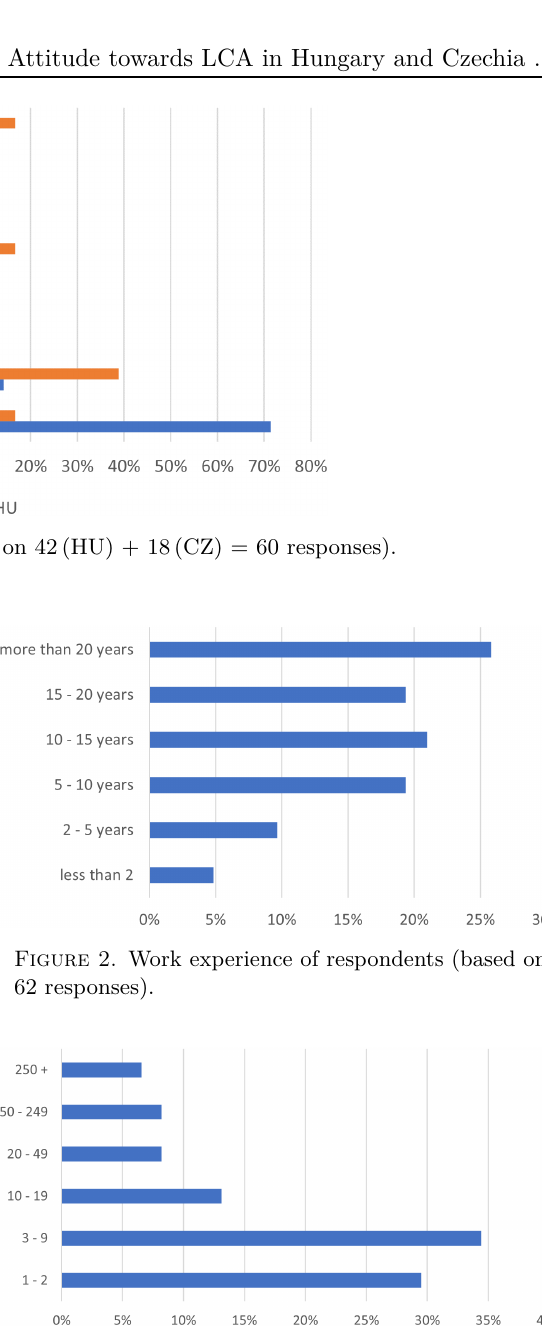
Figure 3. Number of employees in the organisation of the respondents (based on 61 responses).